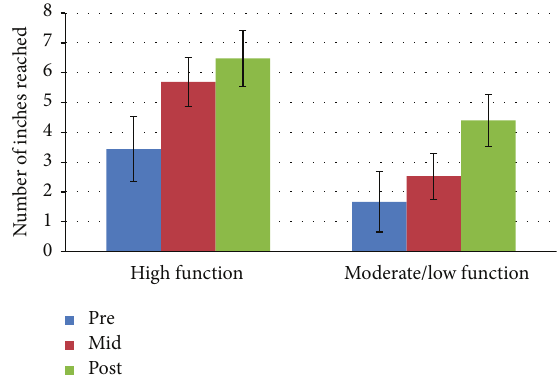
Figure 3: Two-minute step test mean scores by group and time.